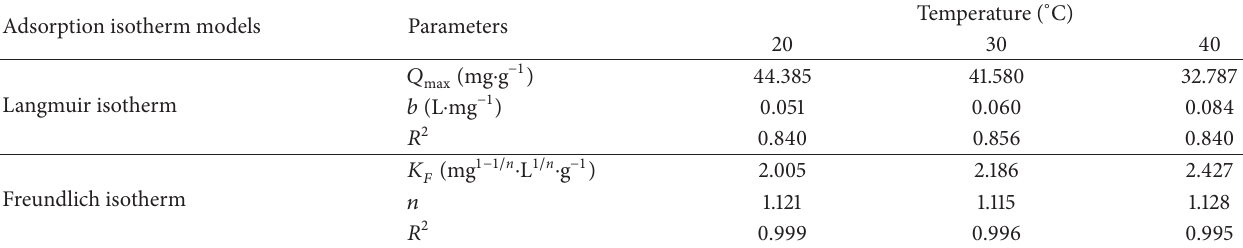
Table 2: The parameters of Langmuir and Freundlich models at different temperatures.